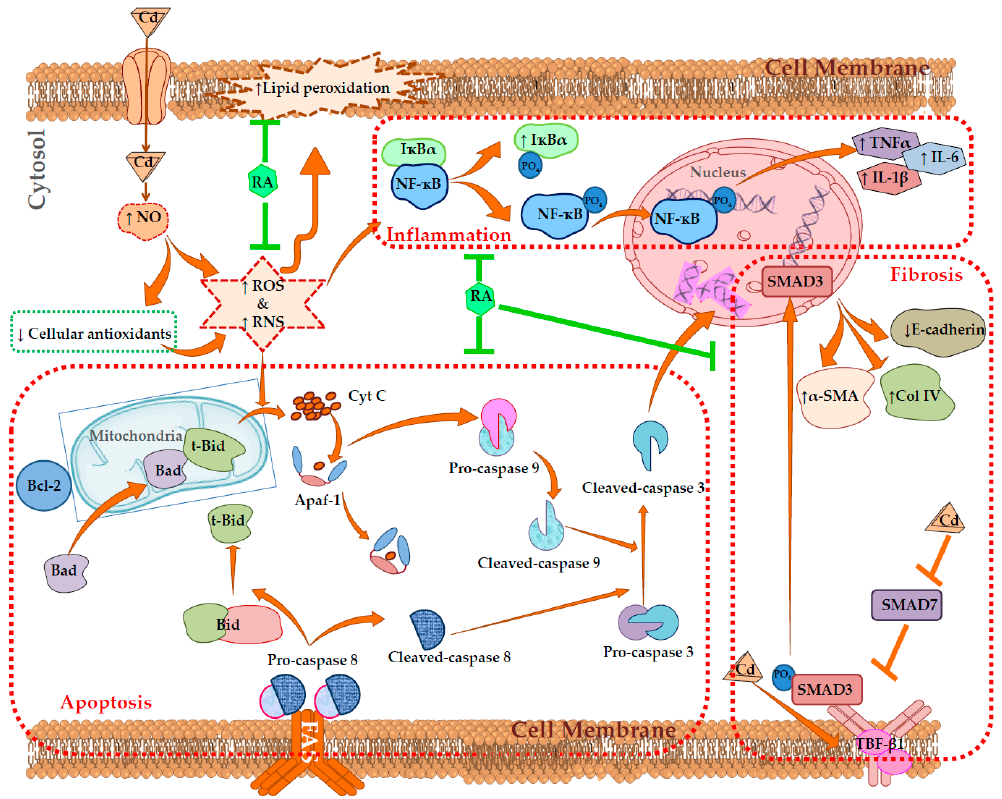
Figure 14. Schematic overview of probable protective mechanism of RA against Cd-mediated renal injury. The brown arrows ( → ) indicate downstream cellular events. The brown lines (T) indicate the activities restricted. The green lines (T) indicate the pathological event restricted by RA.